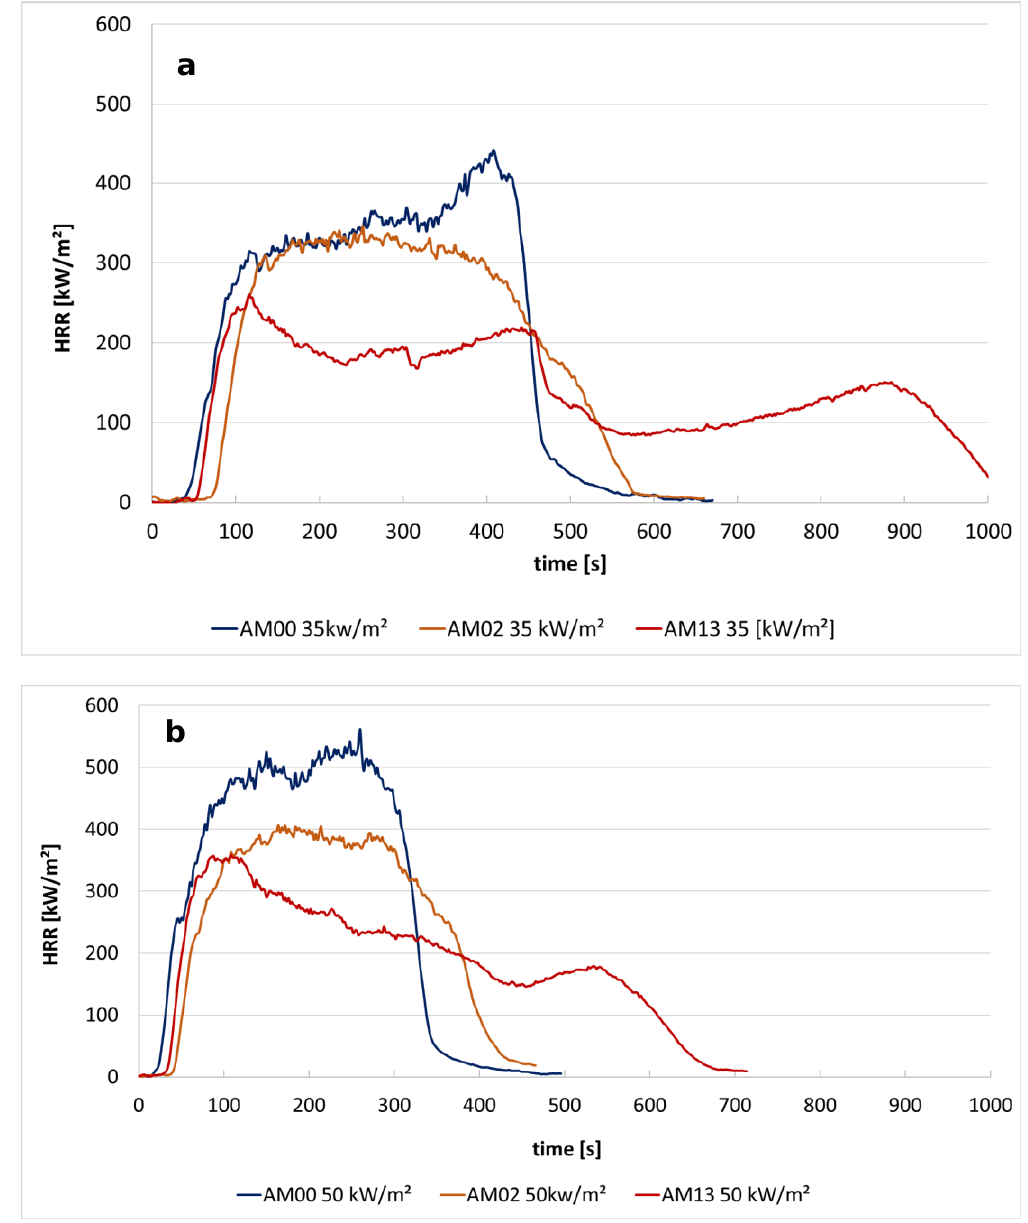
Figure 23. The heat release rate of PP (AM00) and PP with a crosslinker and a flame retardant (AM02 with PP+cross 1.3% + FR1 10% and AM13 with PP + cross 1.3% + FR3 10% + syn 0.8%) at radiation